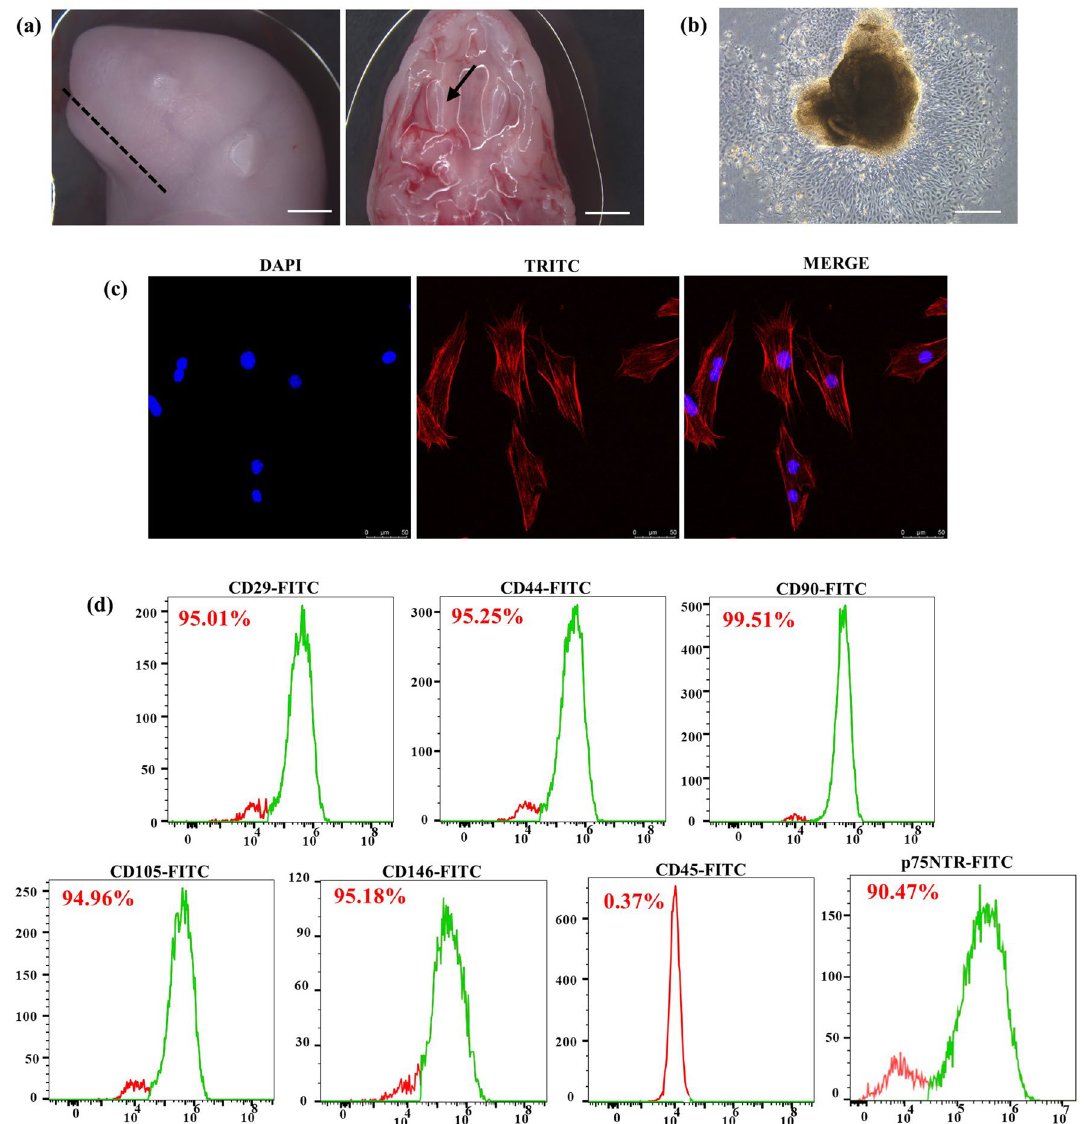
Figure 2. Isolation and characterization of rat embryonic EMSCs. ( a ) The E19.5 d SD rat embryo head and maxillary process. Scale bars: 2.5 mm. ( b ) The E19.5 d EMSCs. Scale bars: 250 μm. ( c ) Phalloidin staining of E19.5 d EMSCs. Scale bars: 50 μm. ( d ) The MSC markers CD29, CD44, CD90, CD105, and CD146 were strongly expressed in EMSCs, while the hematopoietic marker CD45 was hardly detected. The expression of the surface of cranial nerve crest marker p75NTR is